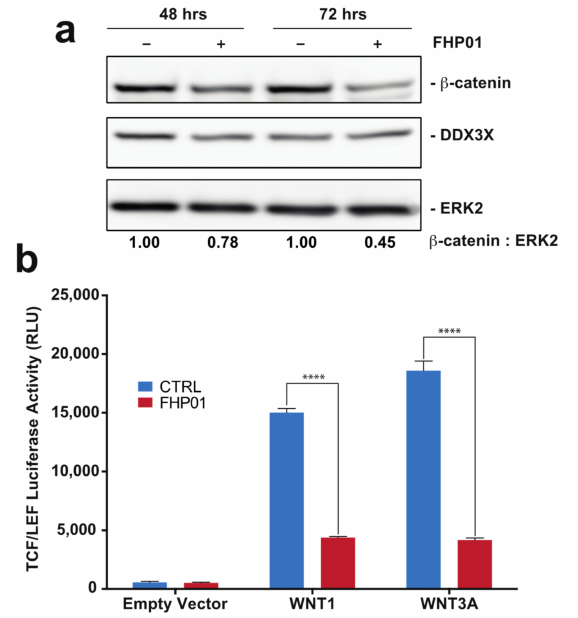
Figure 3. FHP01 inhibits WNT signaling. ( a ) MDA MB 231 cells were incubated with vehicle or the FHP01 DDX3X inhibitor (6 µ M) for indicated times and then immunoblotted to score β -catenin and DDX3X protein levels. Anti-ERK2 immunoblot was also used to normalize total lysates protein levels. Representative images from 3 independent experiments are shown ( n = 3). Intensitometric analysis of β -catenin, normalized by ERK2 protein levels, was performed using NIH ImageJ; ( b ) activation of TCF/LEF luciferase reporter vector after transfection with plasmids coding for the soluble ligands WNT1 and WNT3A, and 6 µ M FHP01 treatment (48 h), as indicated. RLU, relative light units. **** p <